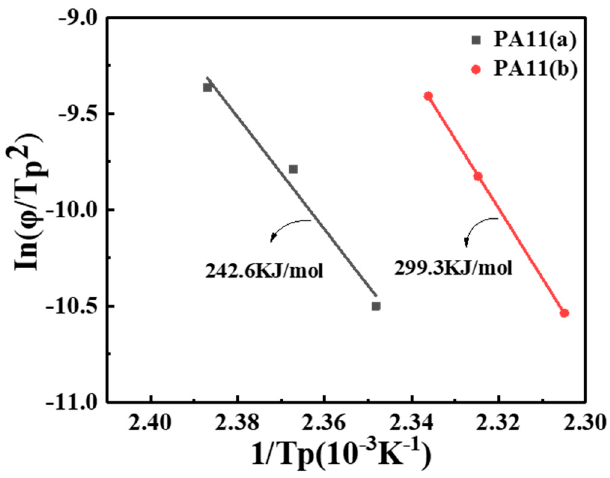
(cid:16) (cid:17) T 2 p versus 1/ T p from the Kissinger method for PA11